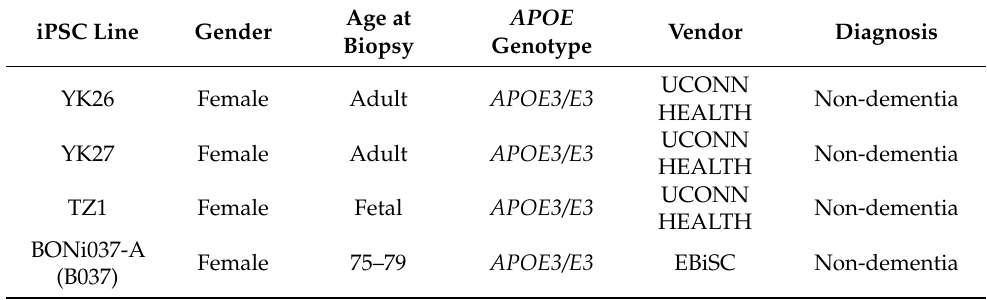
Table 1. List of iPSC